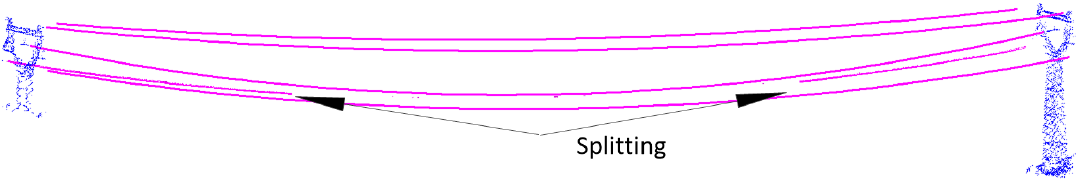
Figure 10. Power-line reconstruction results of splitting spans.